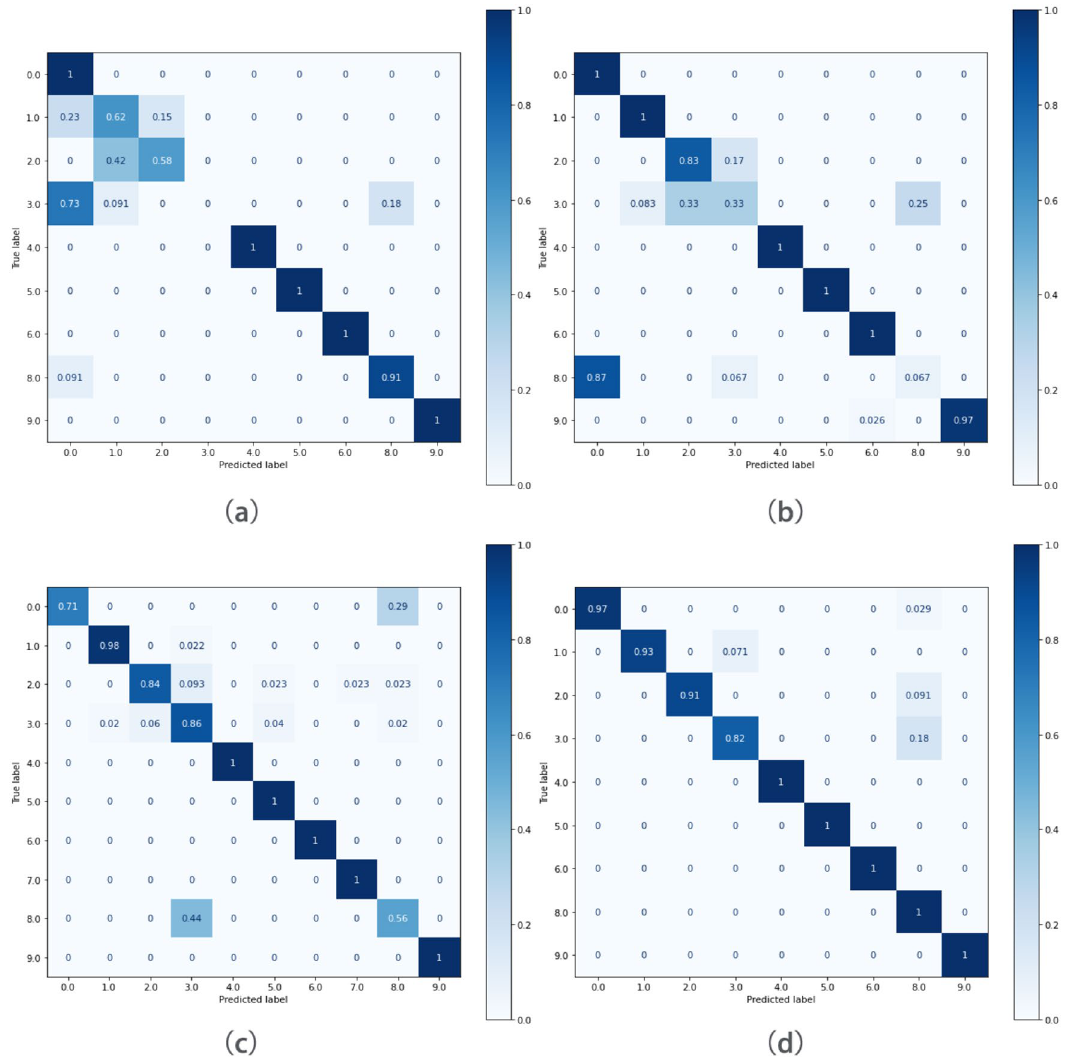
Figure 10. Multi-class confusion matrix of the proposed method: ( a ) SAE+SVM; ( b ) SDAE+SVM; ( c ) CNN; ( d ) Triplet network+SVM.